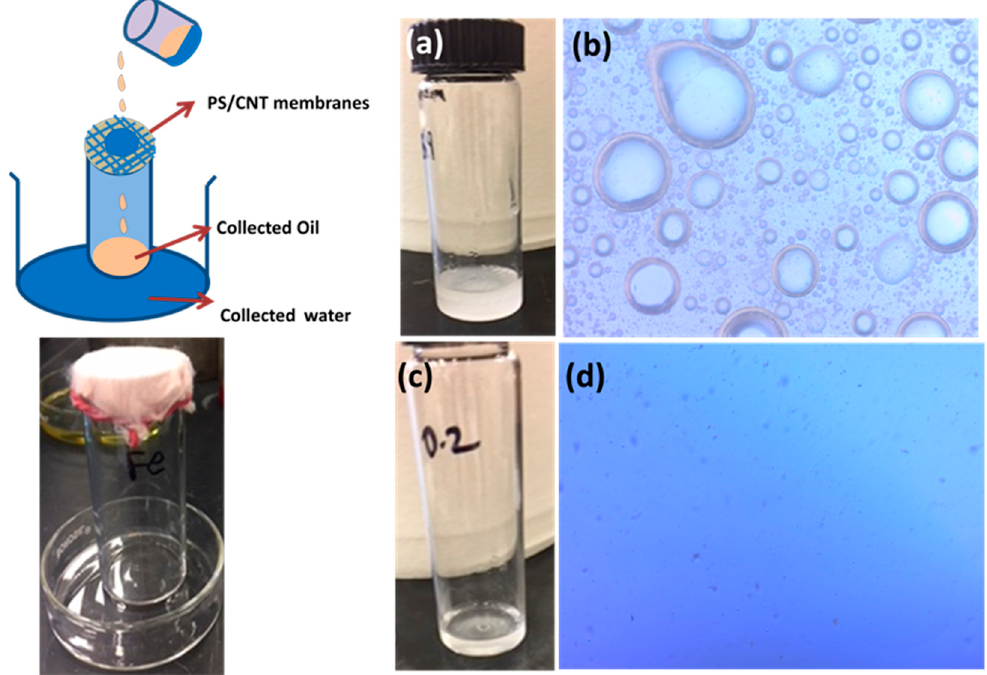
Figure 8. ( a–d ) photographs of oil/water emulsion before and after separation by the membranes (0.5 wt.% of CNT and at 15 KGy irradiated sample).